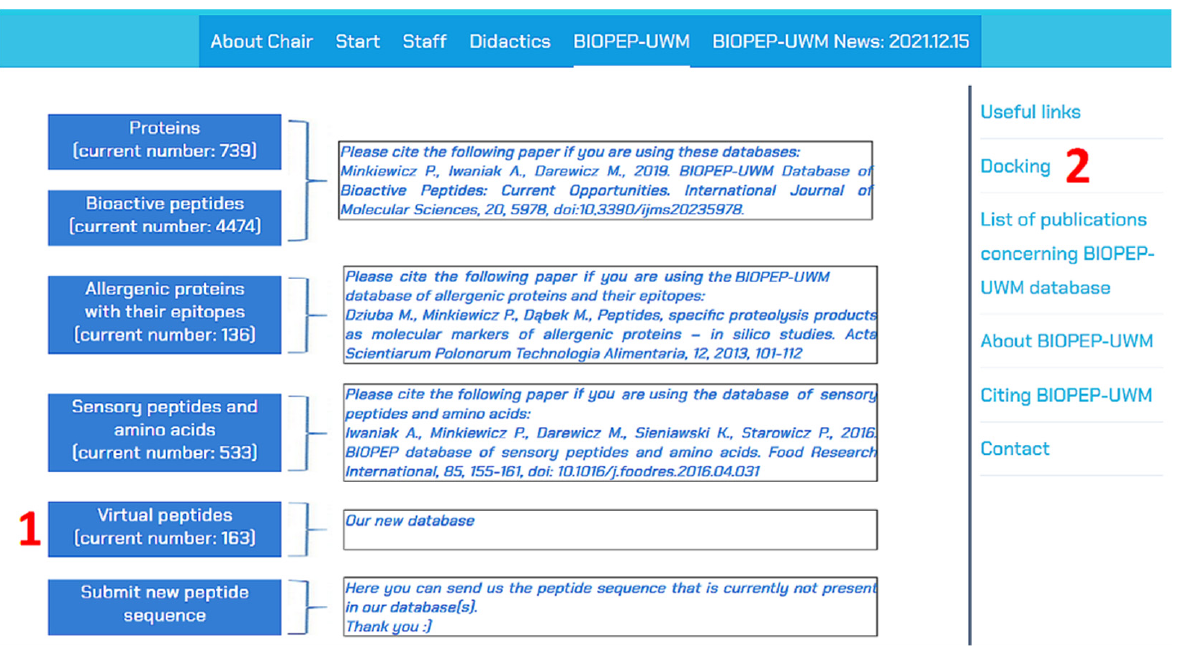
Figure 1. Screenshot of the current homepage of the BIOPEP-UWM database. ( 1 ) BIOPEP-UWM Virtual tab [12,14,15]; ( 2 ) links to programs for molecular docking.